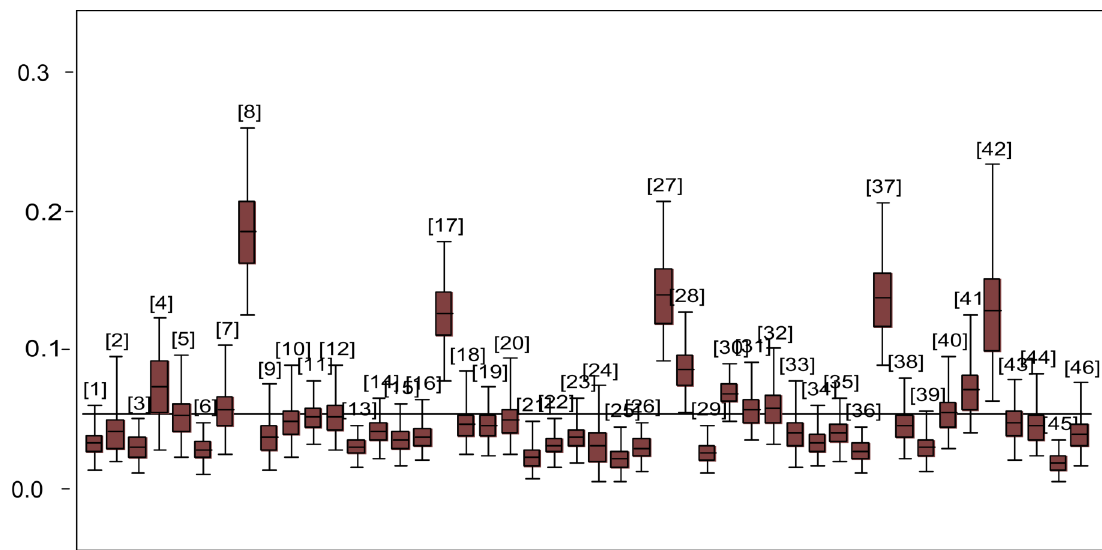
Figure 3. Box plot of HIV prevalence estimates by county. The numbers represent counties (See table 5 for the county numbering codes).